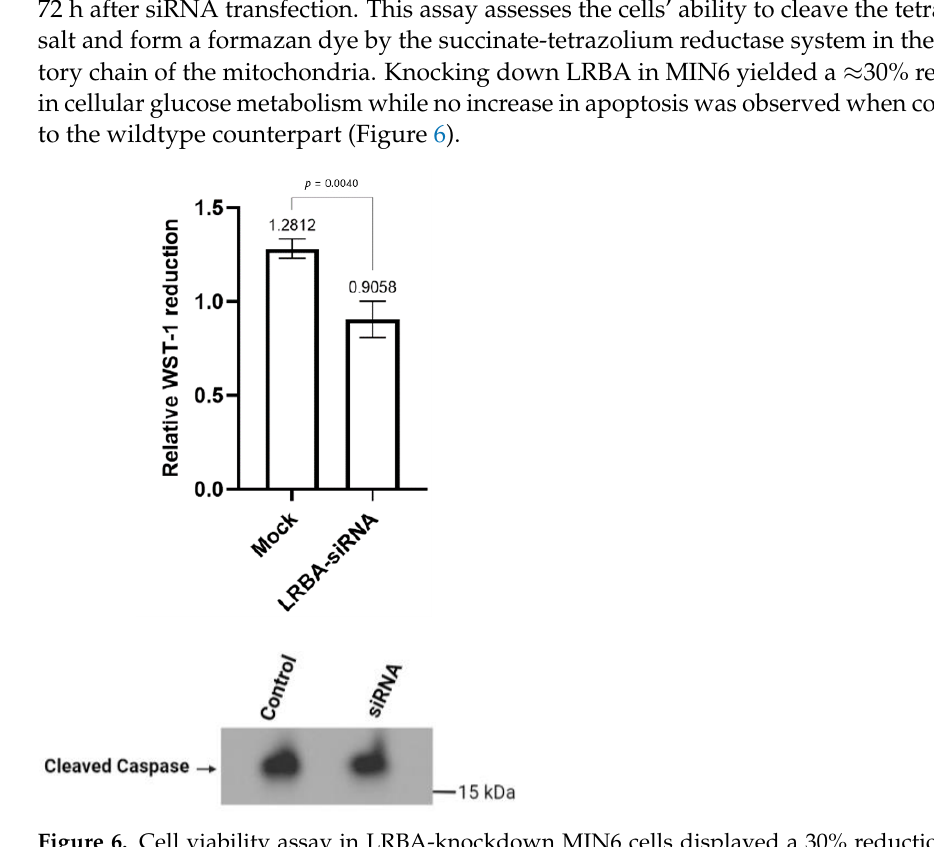
Figure 5. Western blots of insulin from LRBA-knockdown MIN6 pancreatic β -cells. Cells were cultured in 6-well plates and were transfected for 72 h with LRBA-targeted siRNA. Error bars represent S.D. (*: p < 0.05, ns: non significant). Paired parametric t test was used.